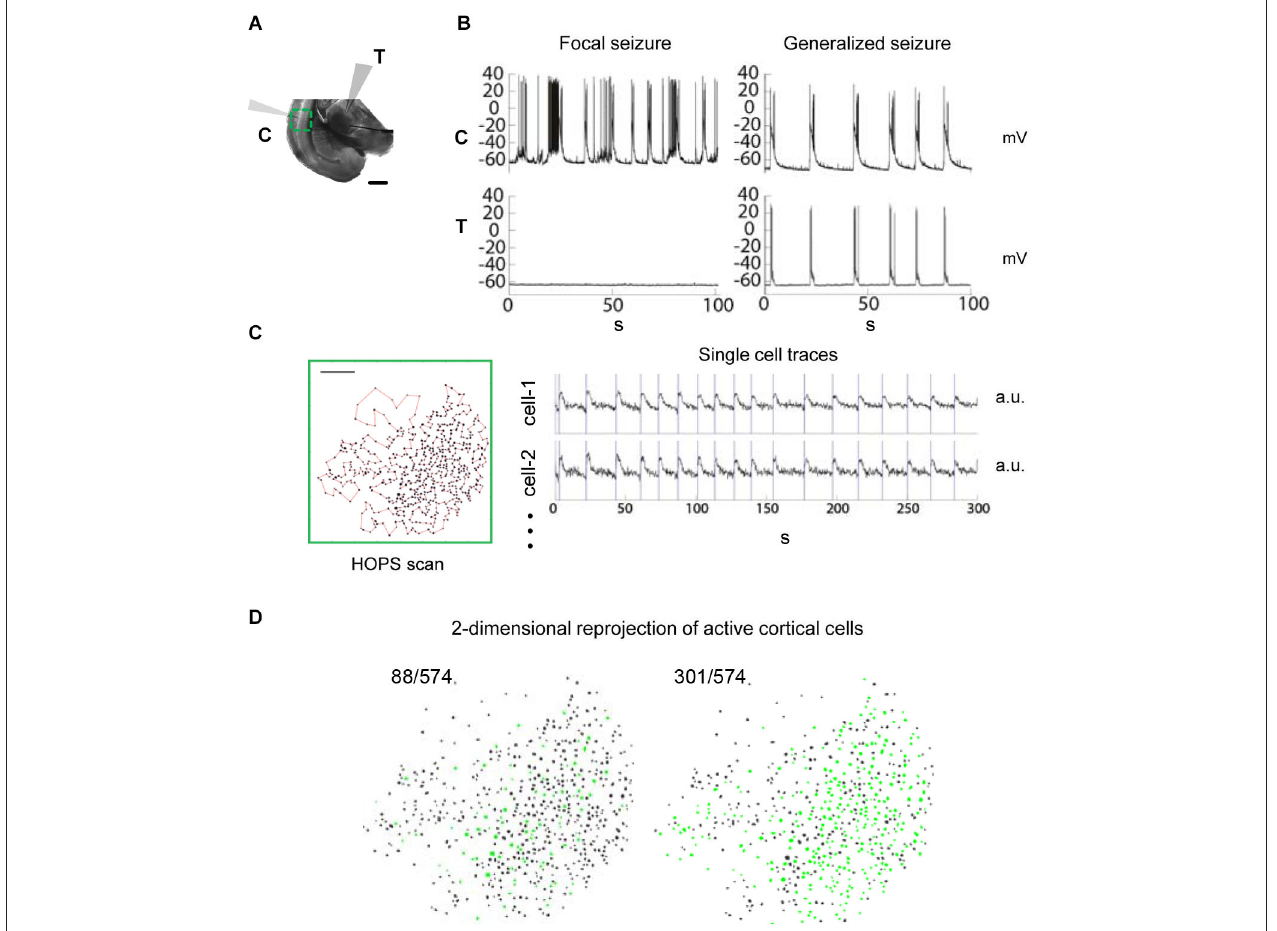
None of the events detected in cortex are seen in thalamus. Right: Generalized seizure with synchronized discharges in thalamus and cortex. (C) Multi-photon calcium imaging using Heuristically Optimal Path Scanning (Sadovsky et al., 2011) reveals cortical circuit dynamics with single cell resolution. Scale bar 200 µ m. 574 neurons, frame rate 13.64 Hz. Example single cell fluorescence traces with discharge onset detections illustrated by vertical bars. (D) 2-dimensional representation of circuit activity. Cells in which activity was detected during cortical discharges are shown in green. The examples represent typical discharges (mean number of active cells) from the recordings shown in (B)